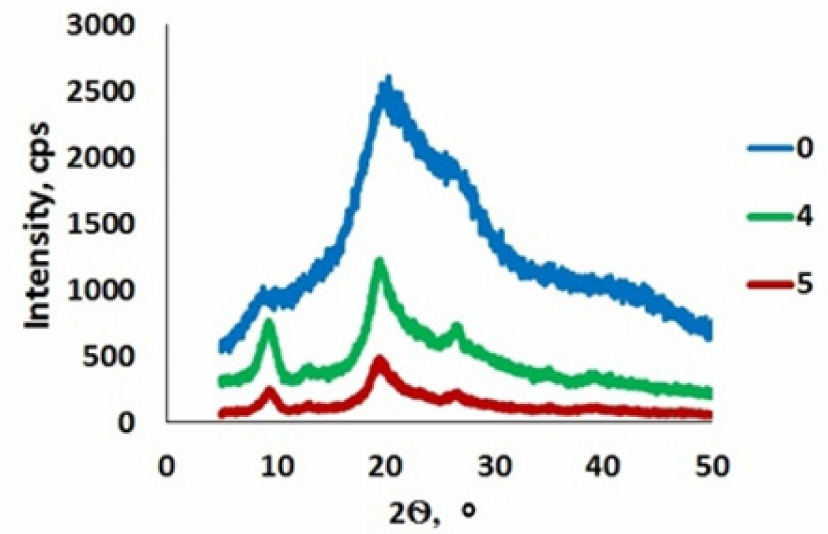
Figure 2. X-ray diffraction patterns of the original chitin (0) and chitin cryogel samples 4 and